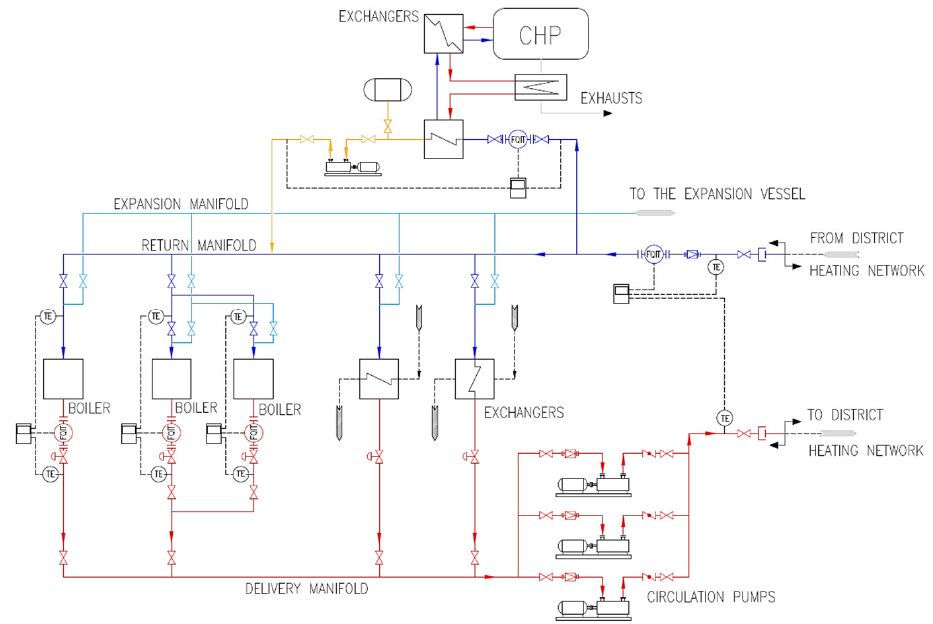
Figure 3. Scheme of the thermal plant connected to the analyzed DH network [32].